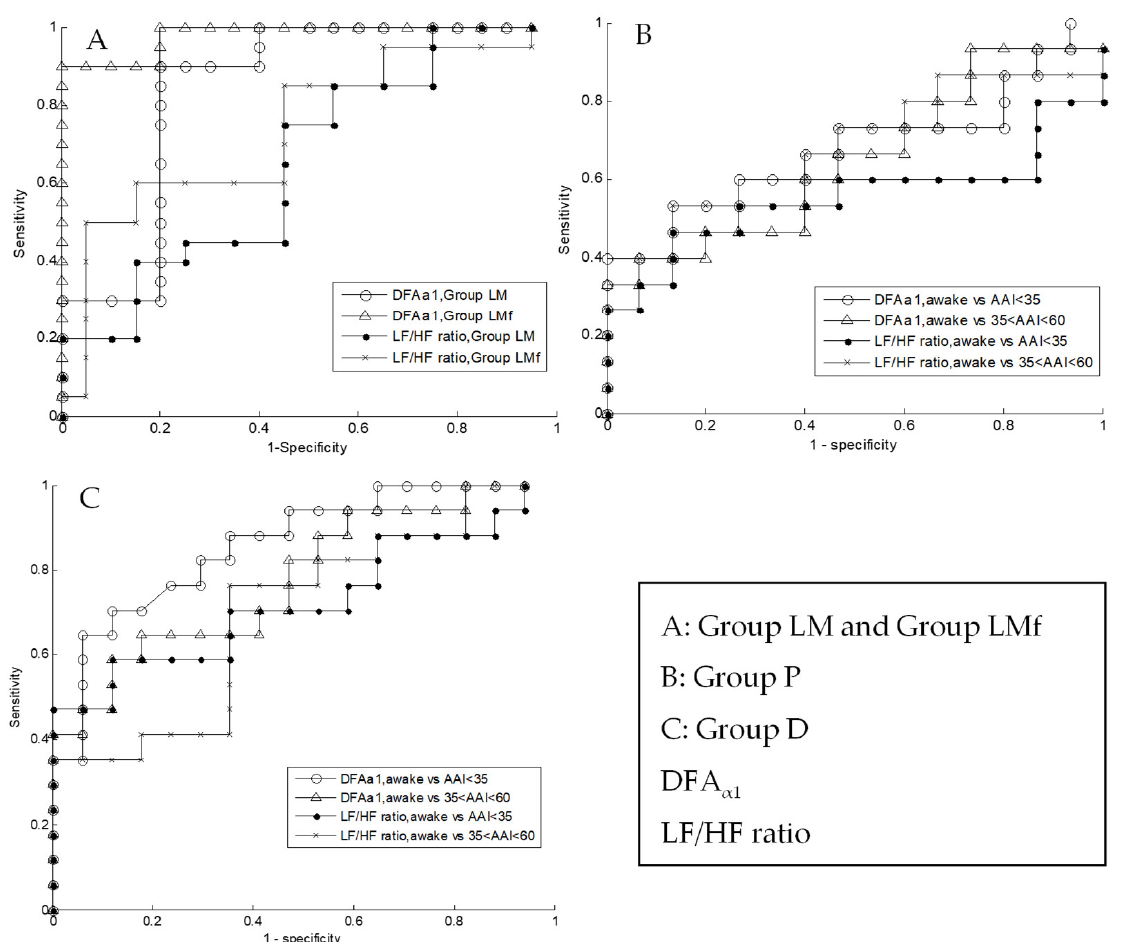
Figure 7. Receiver-operating curves analyses of DFA α 1 and LF/HF ratio at baseline and postspinal ( A ) and general anesthesia ( B , C ) showing fractal analysis of HRV provided a more sensitive and specific information than traditional spectral measurement.